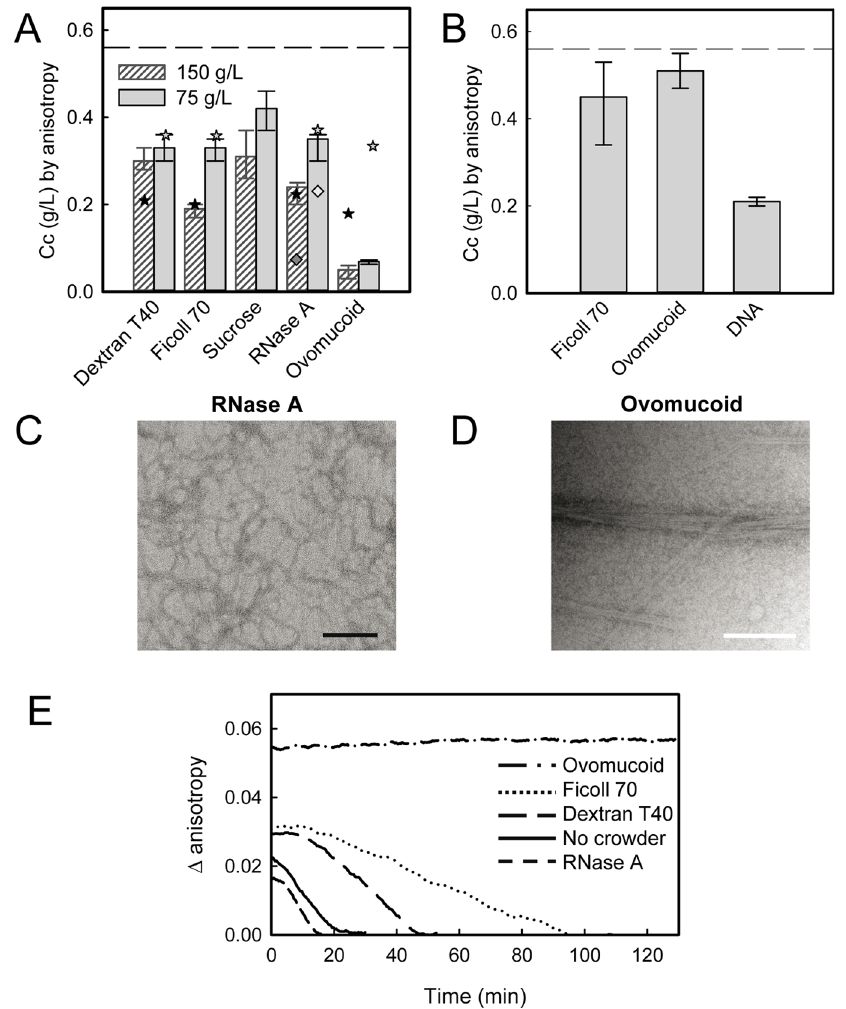
Fig 1. Effect of single crowders on FtsZ polymerization. (A) Effect of the specified crowders on FtsZ Cc of polymerization. Bars correspond to the average ± SD of the values determined for each specific crowder at that particular concentration (Table 1). The dashed line corresponds to the Cc value in the absence of crowder. Stars depict the theoretical Cc values for a pure volume exclusion behavior calculated for each crowder using their partial specific volumes as exclusion volume: υ Dex = 0.61 mL/g [31], υ RNase = 0.703 mL/g [32], υ Ovo = 0.69 mL/g [33], and considering tetramers in the particular case of RNase A (calculated value for RNase monomers is shown as a diamond). Ficoll simulated data were calculated with an exclusion volume of 0.96 mL/g. υ FtsZ = 0.74 mL/g [3]. (B) Cc values ± SD determined with 10 g/L Ficoll or ovomucoid and 11.8 g/L DNA. Dashed line as in A. (C) and (D) Structures induced on GTP-FtsZ polymers by the presence of RNase A (0.5 g/L FtsZ) and ovomucoid (0.25 g/L FtsZ), respectively. Crowder concentration was 150 g/L. Bar 200 nm. (E) Effect of different crowders (150 g/L) on kinetics of depolymerization of FtsZ (1.5 g/L). Profile in the absence of crowder is shown for